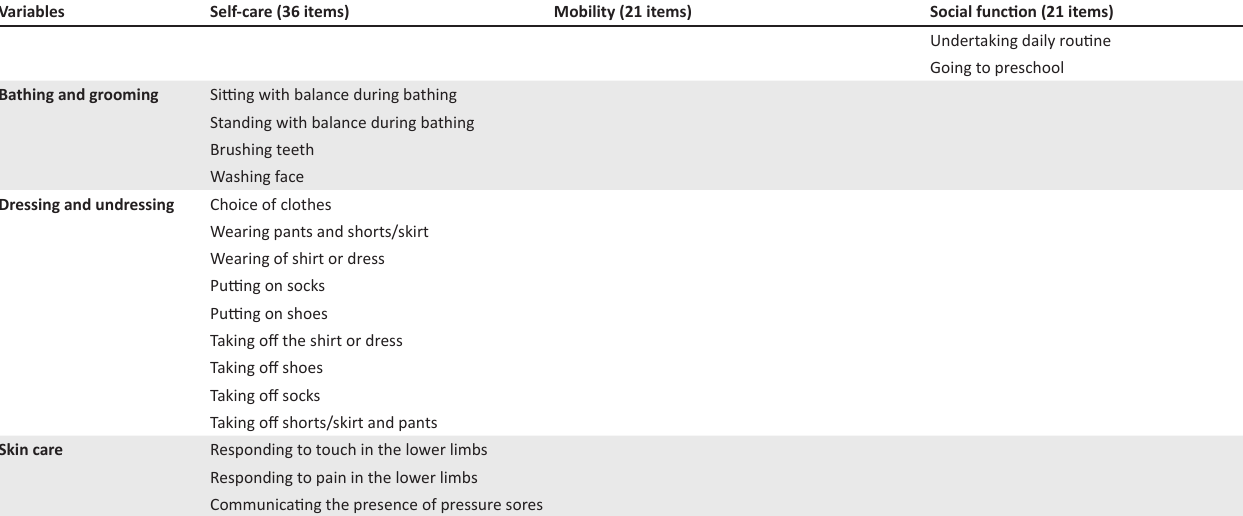
TABLE 6 (Continues...): The 78 items identified for the content validity evaluation.